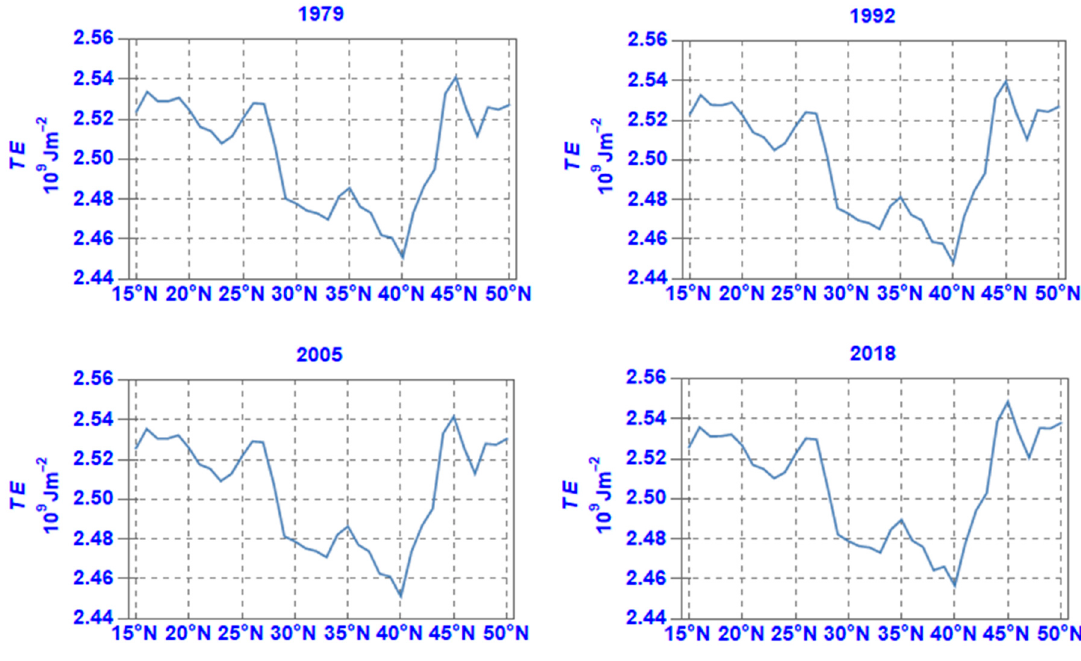
Figure 6. Same as Figure 3 but for TE .